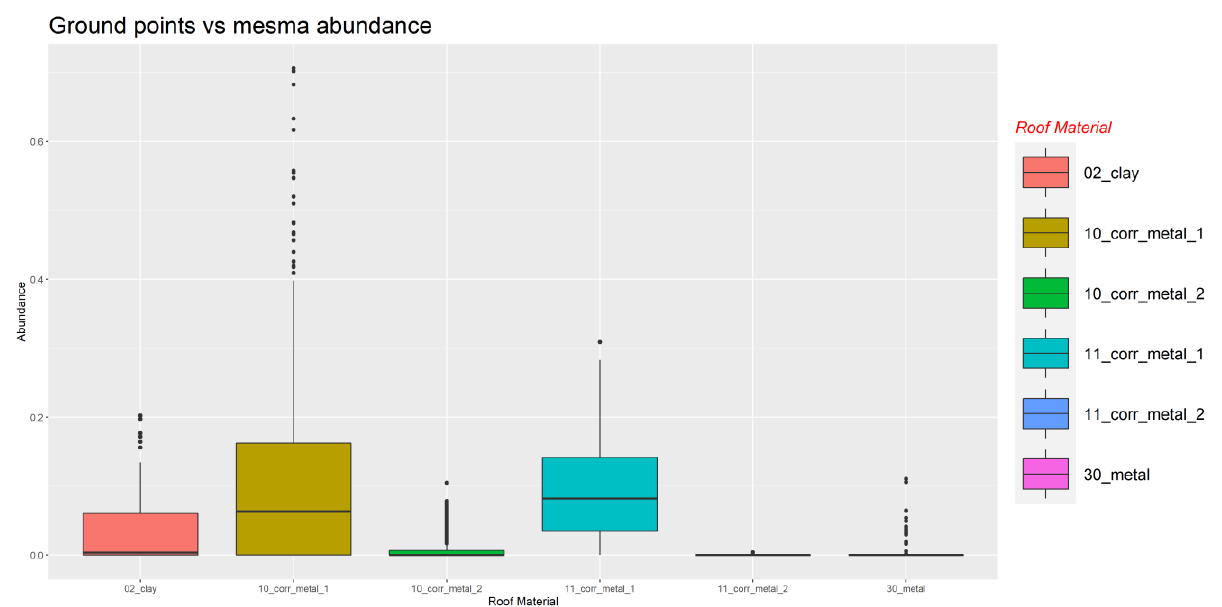
Figure 9: Comparison of clay, bright metals and corrugated metals with abundance